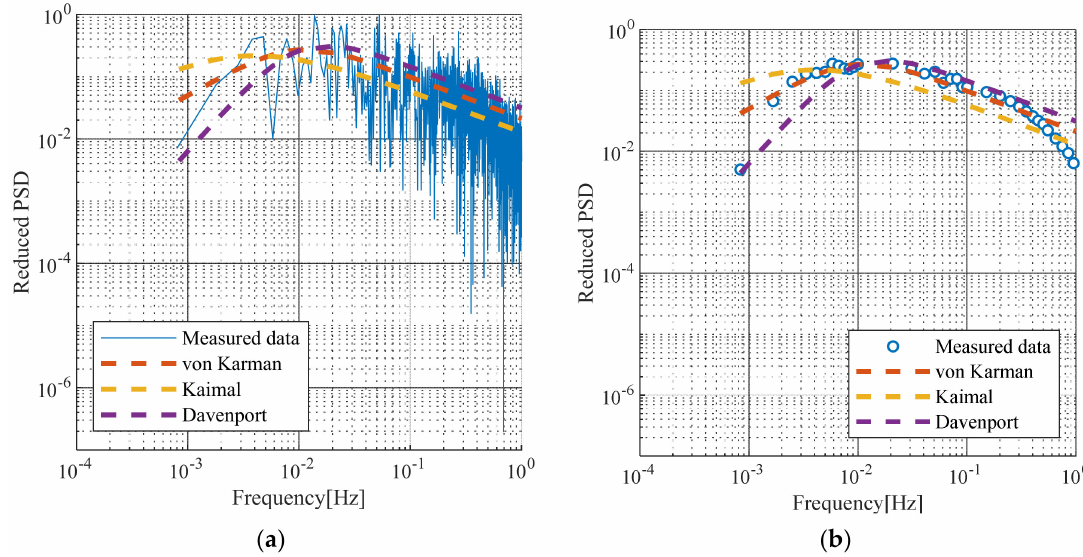
Figure 5. Comparison with turbulence spectra proposed by von Karman [25], Kaimal [26], and Davenport [27]: ( a ) Reduced turbulence spectrum; ( b ) Average reduced turbulence